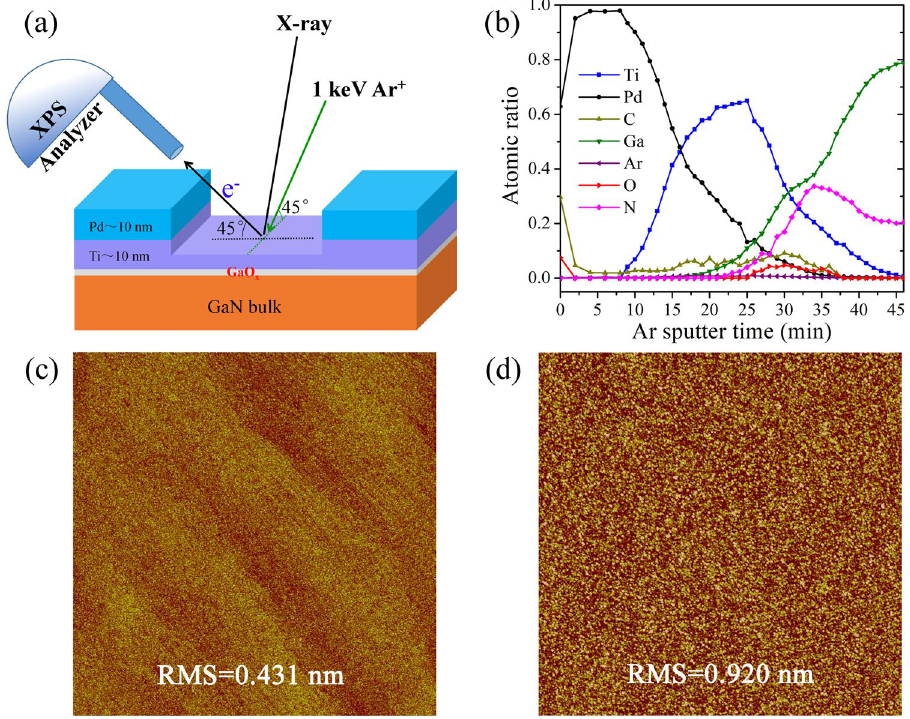
Figure 1. Ar + ion sputter and in-situ XPS depth profile on sample N2. ( a ) Schematic drawing of sputtering geometry. ( b ) XPS depth profile with incident 1 keV Ar + . The surface morphology (5 × 5 μ m 2 ) imaged by AFM after ( c ) 30 min and ( d ) 45 min ion sputtering,